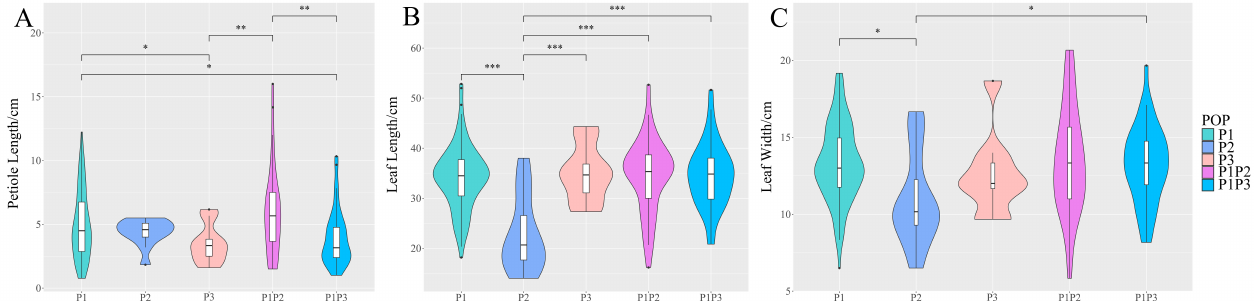
Figure 4. Three leaf-related phenotypes radish subpopulations. ( A )Petiole length. ( B ) Leaf length. ( C ) Leaf width. * p < 0.05; ** p < 0.01; and *** p < 0.001.